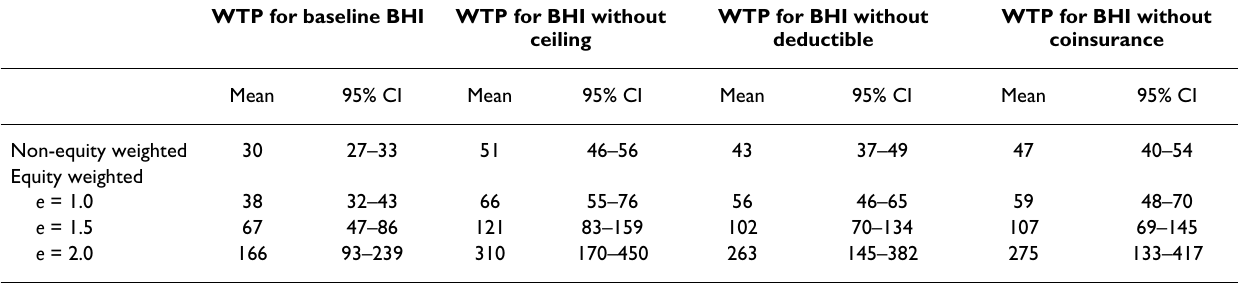
Table 2: Willingness to pay for basic health insurance (N = 609) WTP for baseline BHI WTP for BHI without